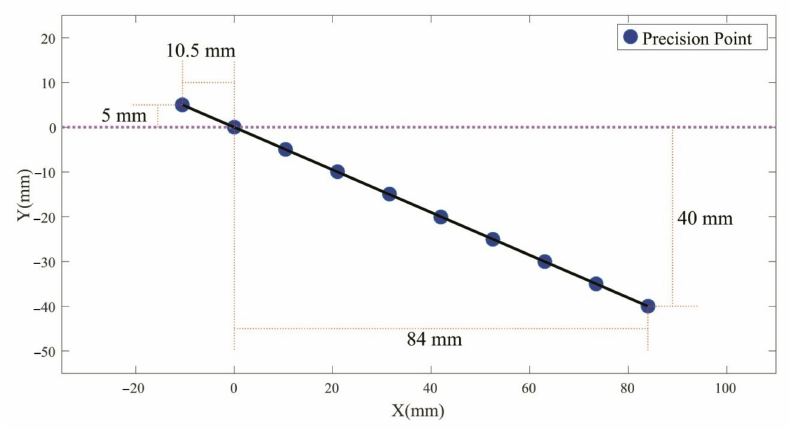
Figure 3. Precise path of the weeding blade’s motion relative to the